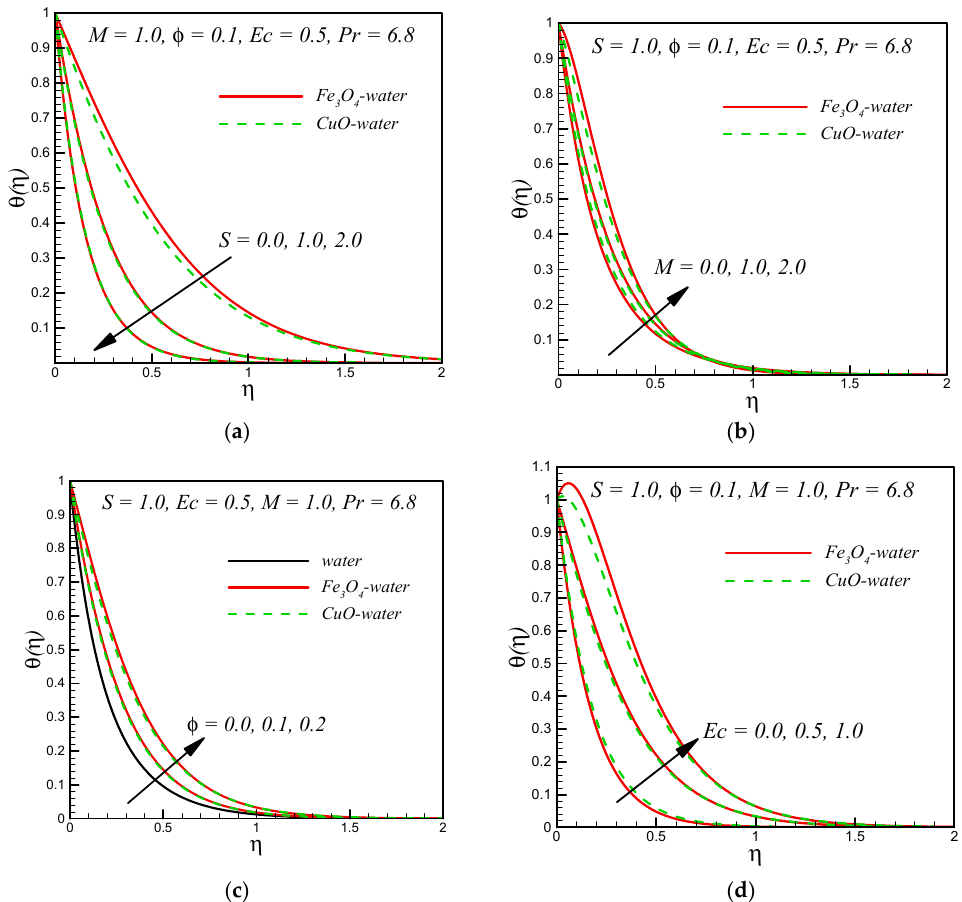
Figure 3. Variation of the temperature profile 𝜃(𝜂) with ( a ) 𝑆 , ( b ) 𝑀 , ( c ) 𝜙 ,and ( d ) 𝐸𝑐 .